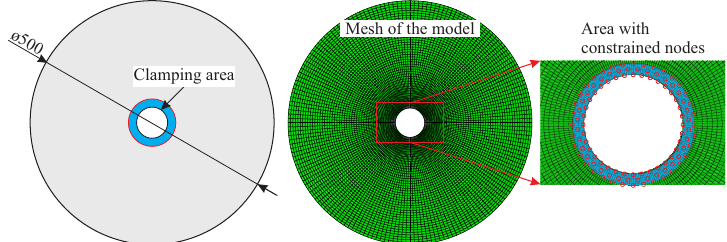
Figure 8. Schematic illustration of the rotor geometry ( left ); generated FE-mesh for the investigated rotors, with one element in the thickness direction and an approximate element thickness of 5 mm ( middle ); and the boundary conditions of the FE model ( right